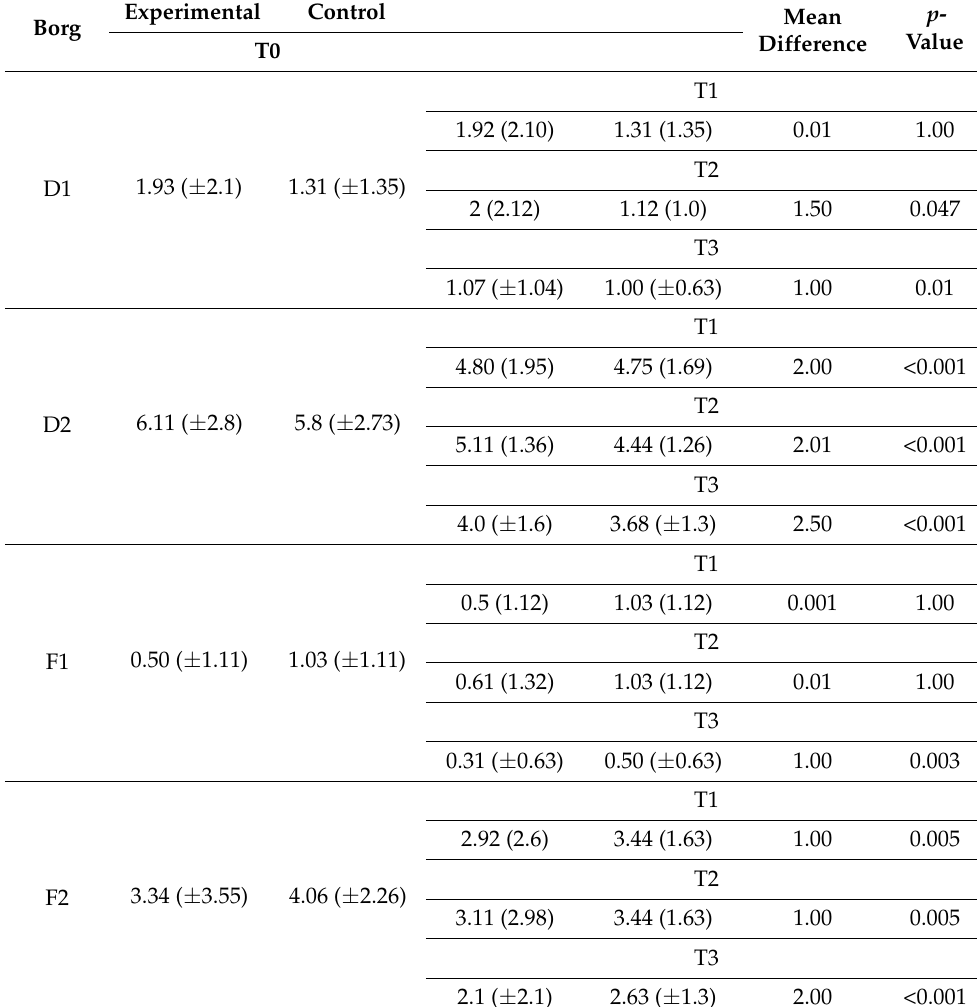
Table 3. Borg scale variations between baseline (T0) and follow-up periods (T1,T2,T3. Borg scale results reported for the groups as the mean difference ( ± SD): mean difference and corresponding p -value. D1: dyspnea pre-6MWT; D2: dyspnea post-6MWT; F1: fatigue perception pre-6MWT; F2: fatigue perception